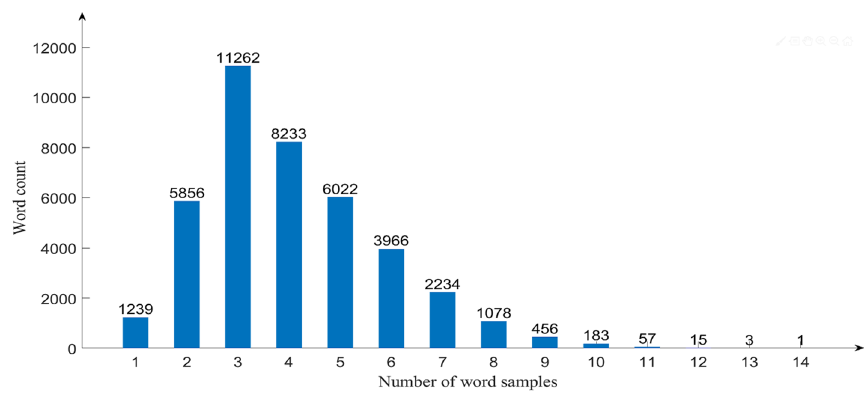
Figure 8. Word sample